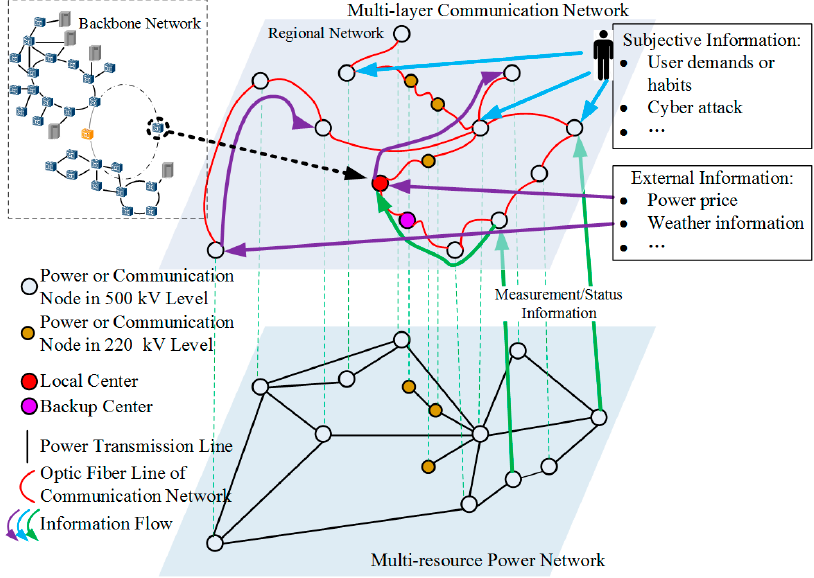
Figure 1. Typical structure of a cyber physical power system of a real utility in China.